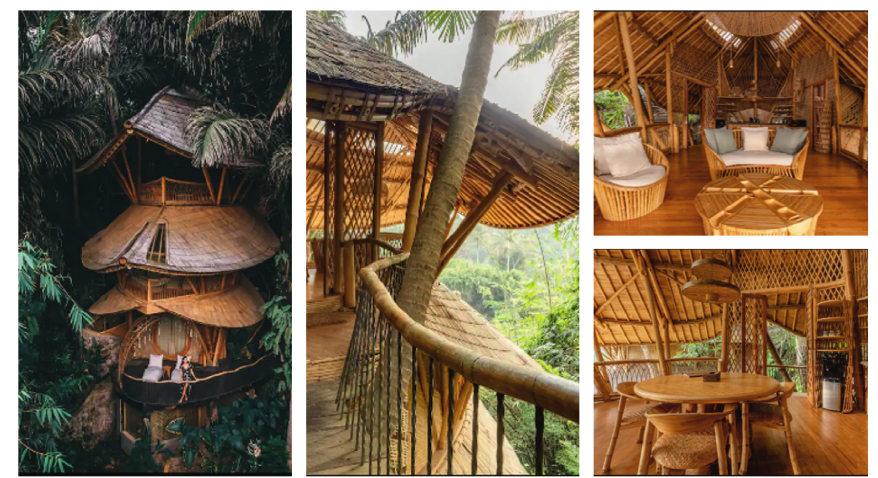
Figure 2: Aura House, 2bds eco bamboo